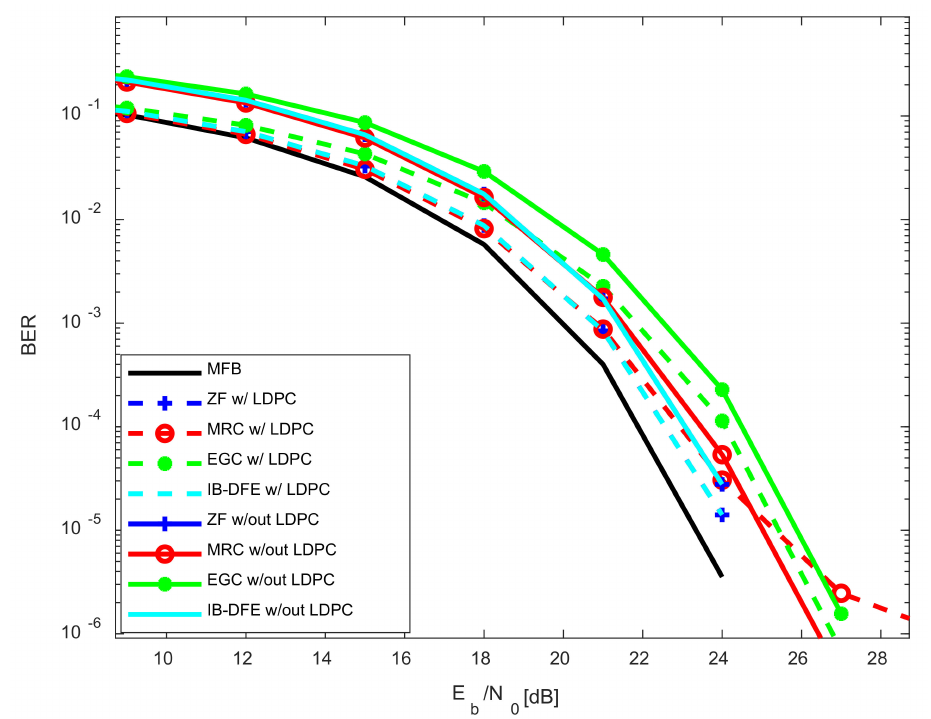
Figure 6. Results for 4 × 32 MIMO, with and without LDPC codes, with impulsive noise, with channel estimation, and with channel correlation 0.3 between antenna elements.